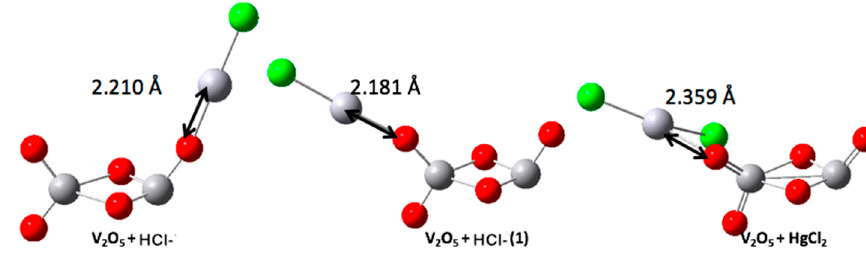
Figure 7. Reaction model of V 2 O 5 and HgCl, HgCl 2.